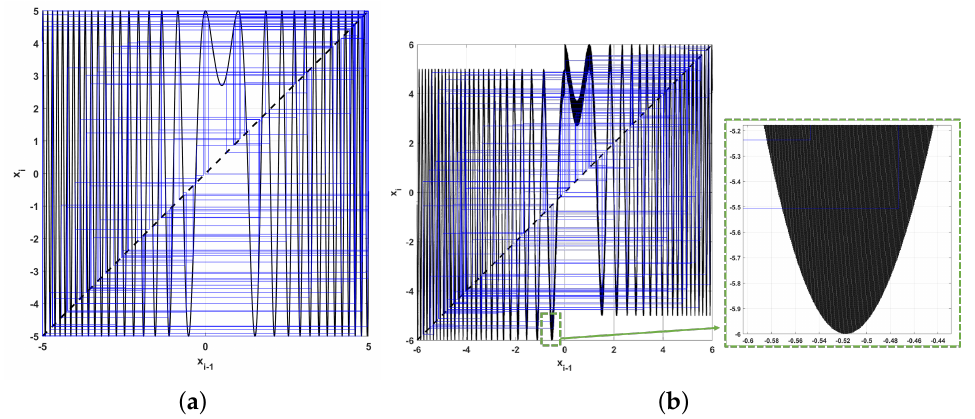
Figure 15. Cobweb diagrams for ( a ) the cosine-logistic map (28) and ( b ) modified cosine-logistic map (29), for k = 5, a = 2000, N = 1, r = 4.